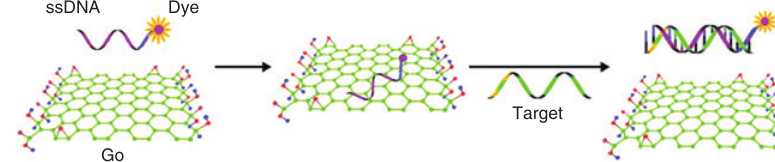
Figure 1: Schematic representation of target-induced fluorescence change of ssDNA-FAM-GO complex. Reprinted with permission of Ref. [15]. © Copyright 2009 Wiley-VCH Verlag GmbH & Co.